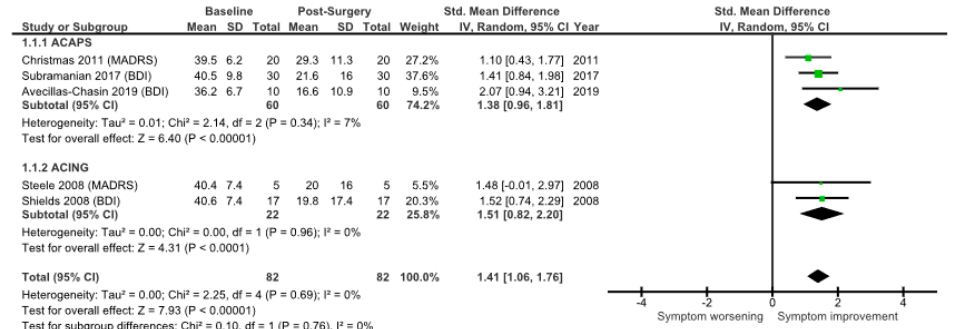
Figure 5. Standardised mean difference in depression scores pre- and post-ablative surgery for ACAPS and ACING. All patients (single procedure and LOCF) included. The mean change for each study is represented by a green box. More powerful studies are indicated by a larger sized box, and they contribute to the pooled result to a greater degree [10,18–21].